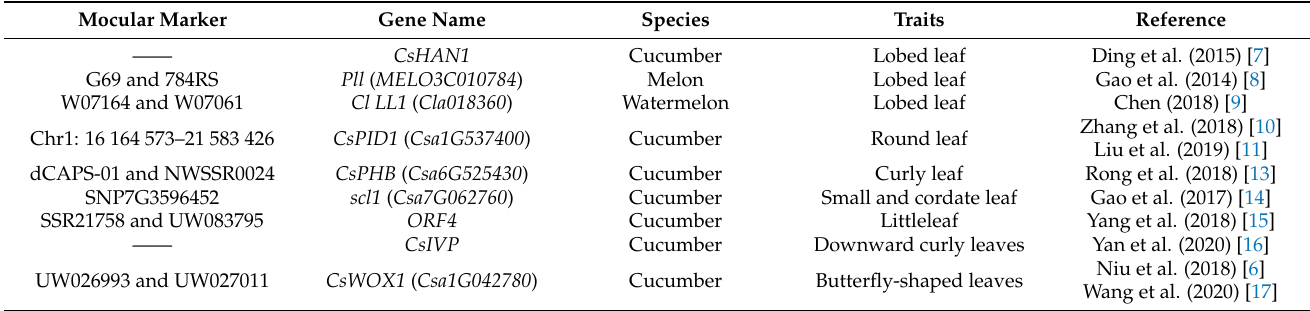
Table 1. Genes involved in leaf shape regulation of